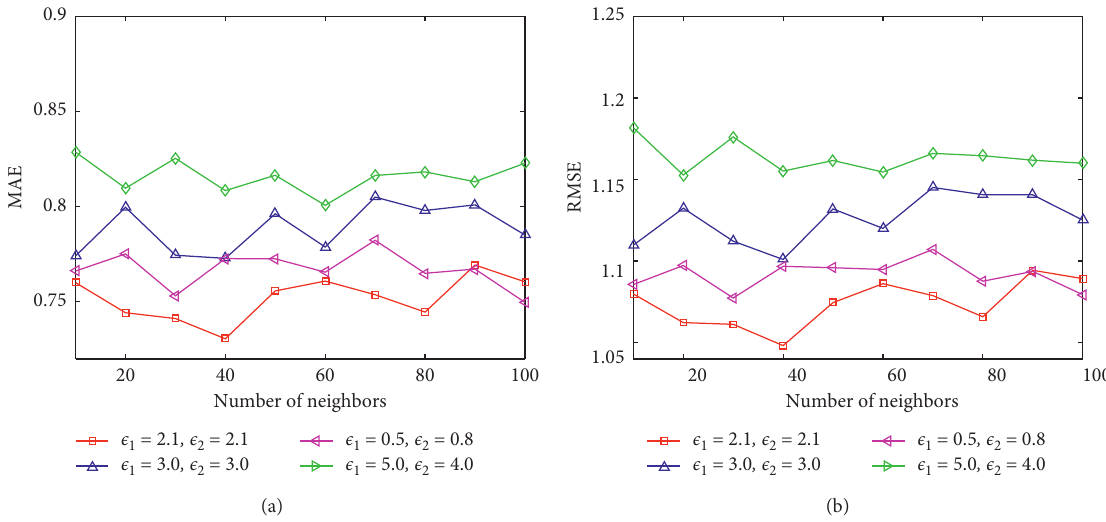
Figure 5: CiaoDVD-1. (a) MAE results between different values of ε